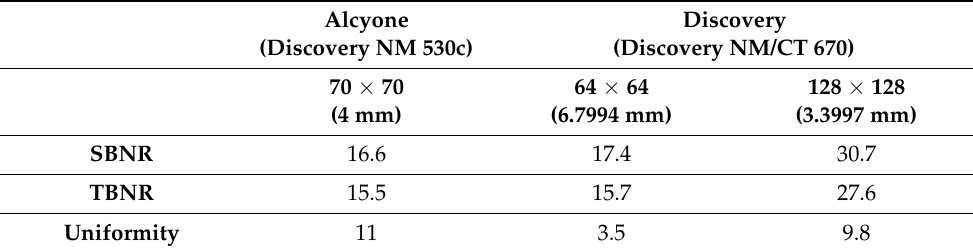
Table 7. SBNR, TBCNR, and uniformity indexes from cardiac